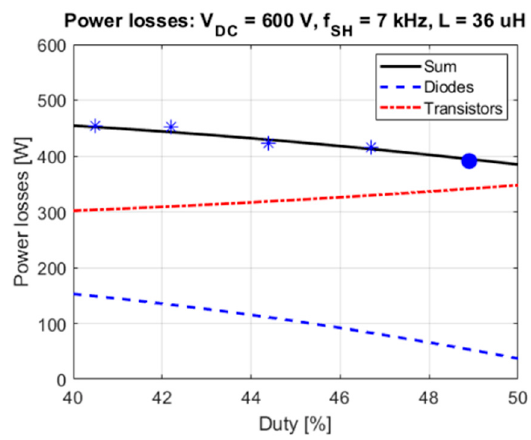
Figure 9. Power losses in the half-bridge: transistors (red), diodes (blue) and the sum of power losses in the module (black) obtained from calculations in MATLAB and experiments (blue dot and stars).